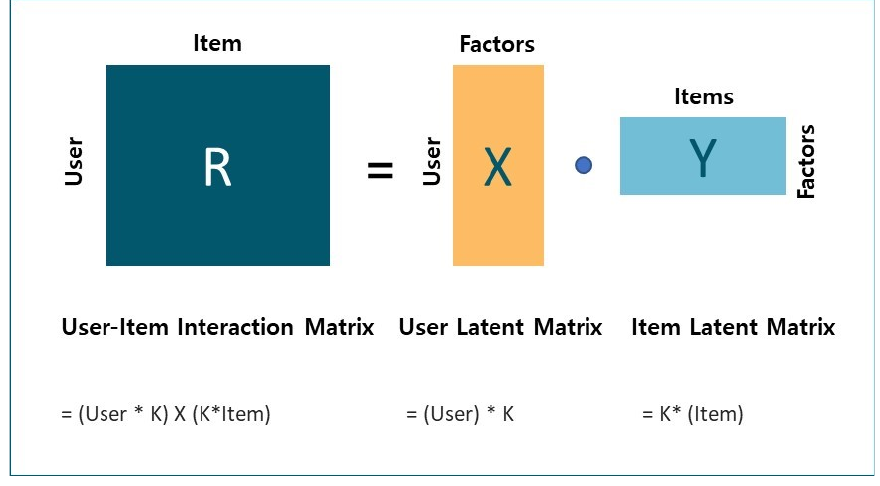
Figure 1. Structure of Matrix Factorization.